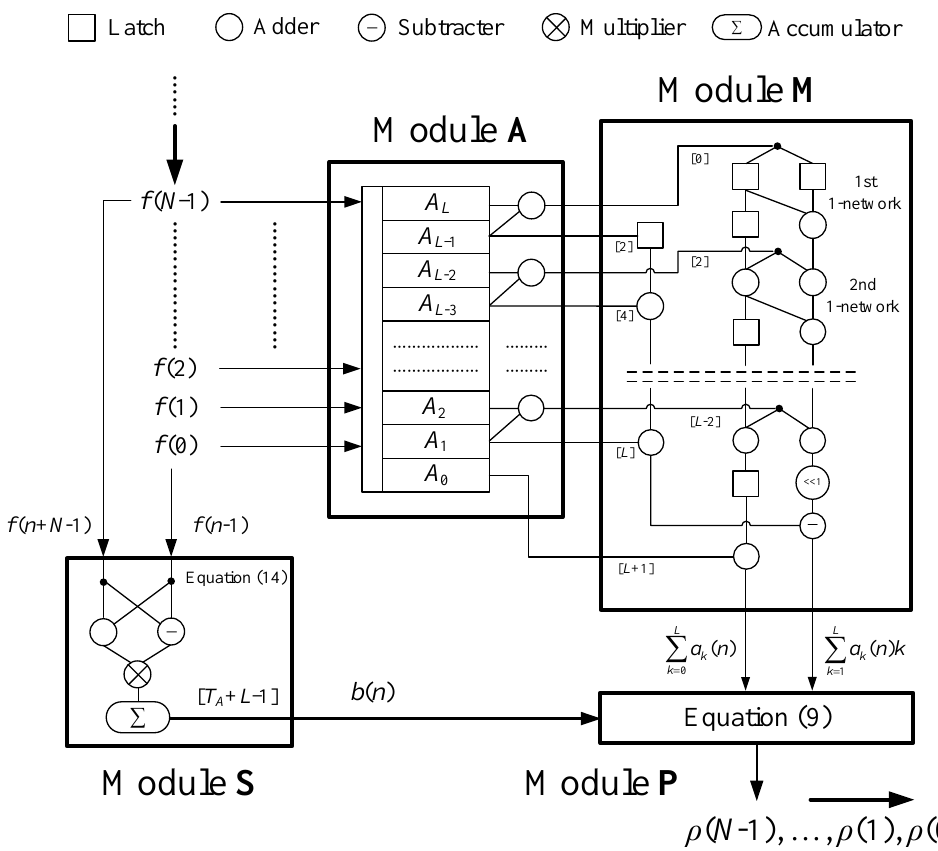
Figure 6. The systolic array for fast normalized cross-correlations (NCCs).